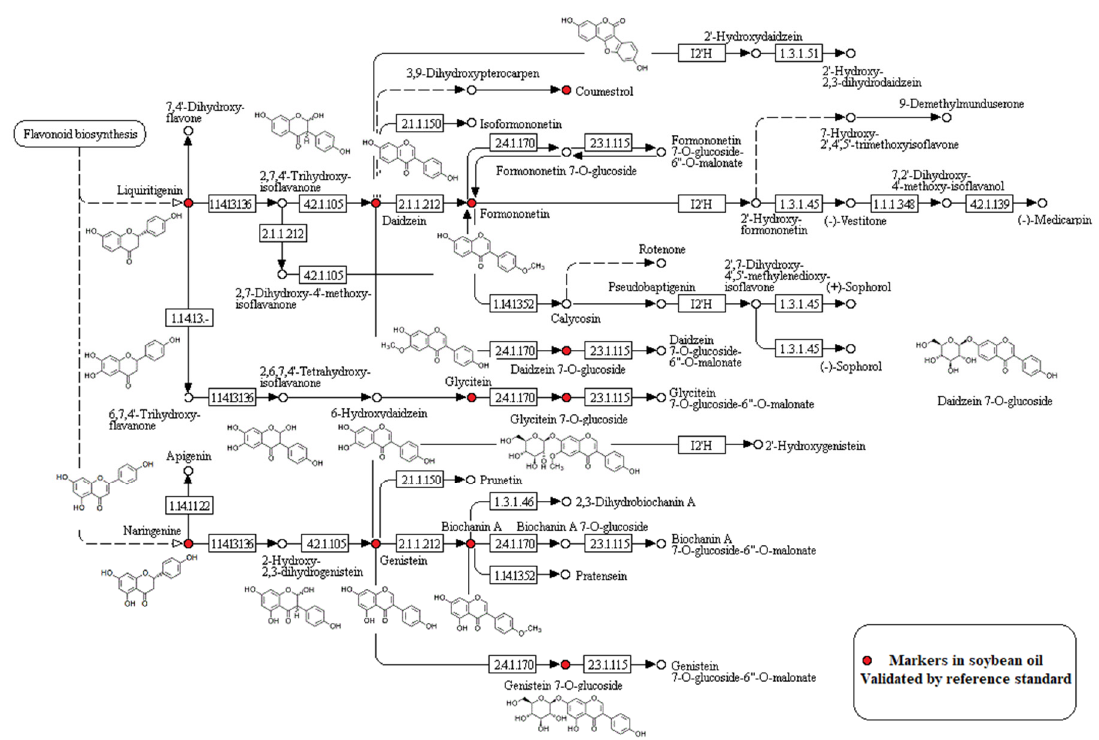
Figure 3. Distribution for metabolic markers of soybean oils in the isoflavonoid biosynthesis pathway, adapted from Kyoto Encyclopedia of Genes and Genomes (KEGG) database [41].